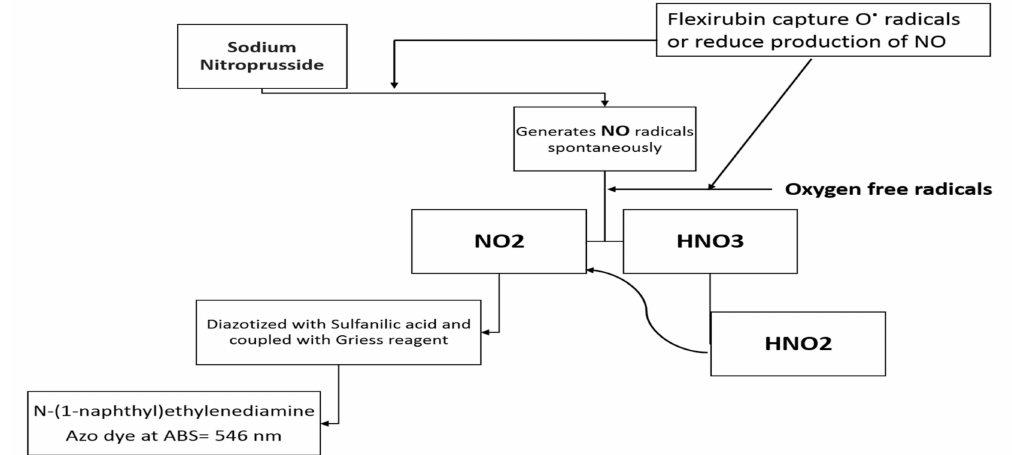
Figure 4. Expected flexirubin mode of action in nitric oxide scavenging